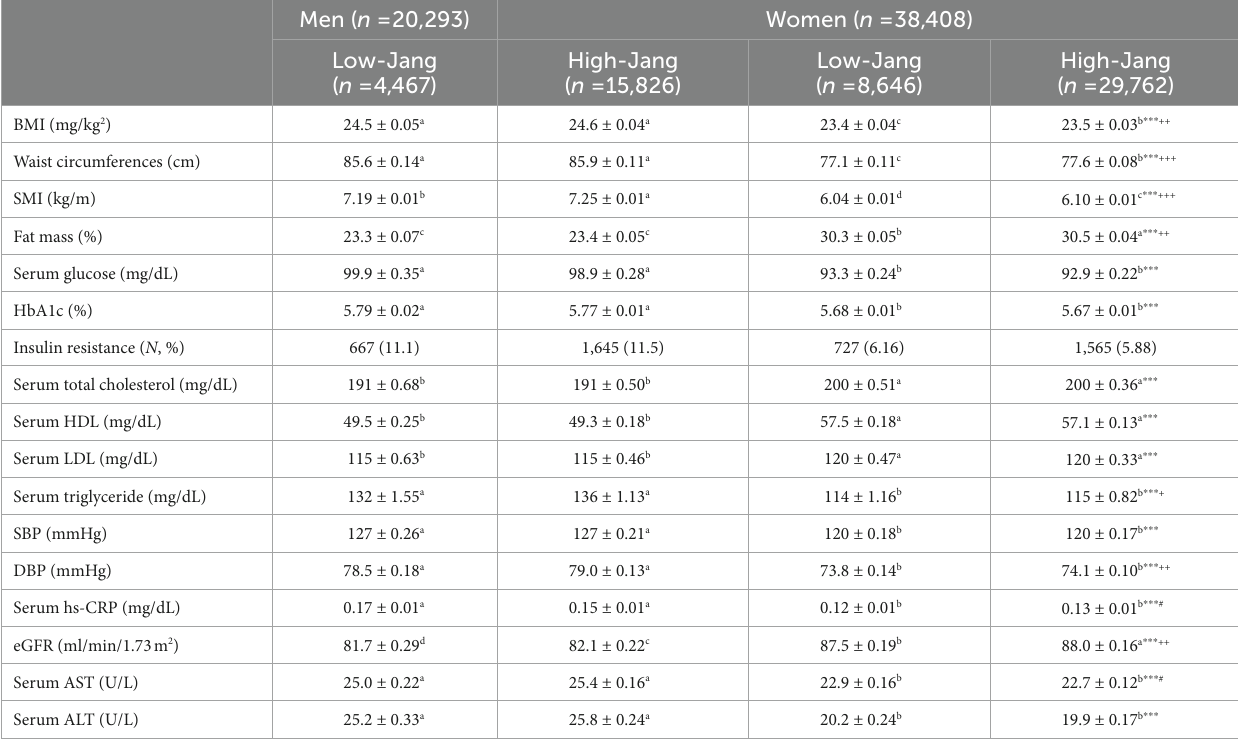
Values represent means and standard deviations for continuous variables and numbers and percentages for categorical variables. Covariates for adjustment included age, energy intake, residence area, education, income, sodium and alcohol intake, smoking status, and physical activity. The cutoff of sodium intake was <1.5 g/day. BMI, body mass index, SMI, skeletal muscle index; HbA1c, hemoglobin A1c; HOMA-IR, Homeostatic Model Assessment for Insulin Resistance (cutoff: 2.32 of HOMA-IR); HDL, high-density lipoprotein; LDL, low-density lipoprotein; SBP, systolic blood pressure; DBP, diastolic blood pressure; hs-CRP, high-sensitive C-reactive protein; AST, aspartate aminotransferase; ALT, alanine aminotransferase. ‡ Significantly different from the